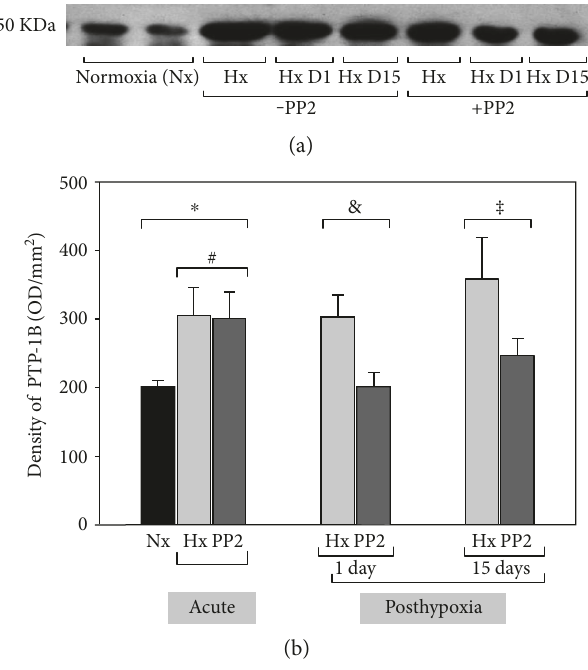
Figure 2: (a) Immunoblotting was performed with an antibody speci fi c for the PTP-1B. One band was identi fi ed at 50 kDa corresponding to the active PTP-1B. Results are expressed as OD values (mean ± SD). In this fi gure, also, we include data from piglets that were left to recover after 1 hour of hypoxia (for 1 day and for 15 days). (b) There was an increased expression of PTP- 1B acutely after hypoxia that was maintained up to 15 days. Pretreatment with a Src inhibitor (PP2) did not a ff ect the expression of PTP-1B in the acute phase 1 hour after hypoxia but blocked the expression of PTP-1B at 1 day posthypoxia. There was a trend for decreased PTP-1B expression at 15 days in piglets that were pretreated with PP2, but this did not reach statistical signi fi cance. Acute groups: ∗ P < 0 05 Hx and Hx+PP2 versus Nx. # NS Hx versus Hx+PP2. Recovery 1 day: & P < 0 05 Hx D1 versus Hx D1+PP2 and Nx. Recovery 15 days: ‡ NS Hx D15 versus Hx D15+PP2 and